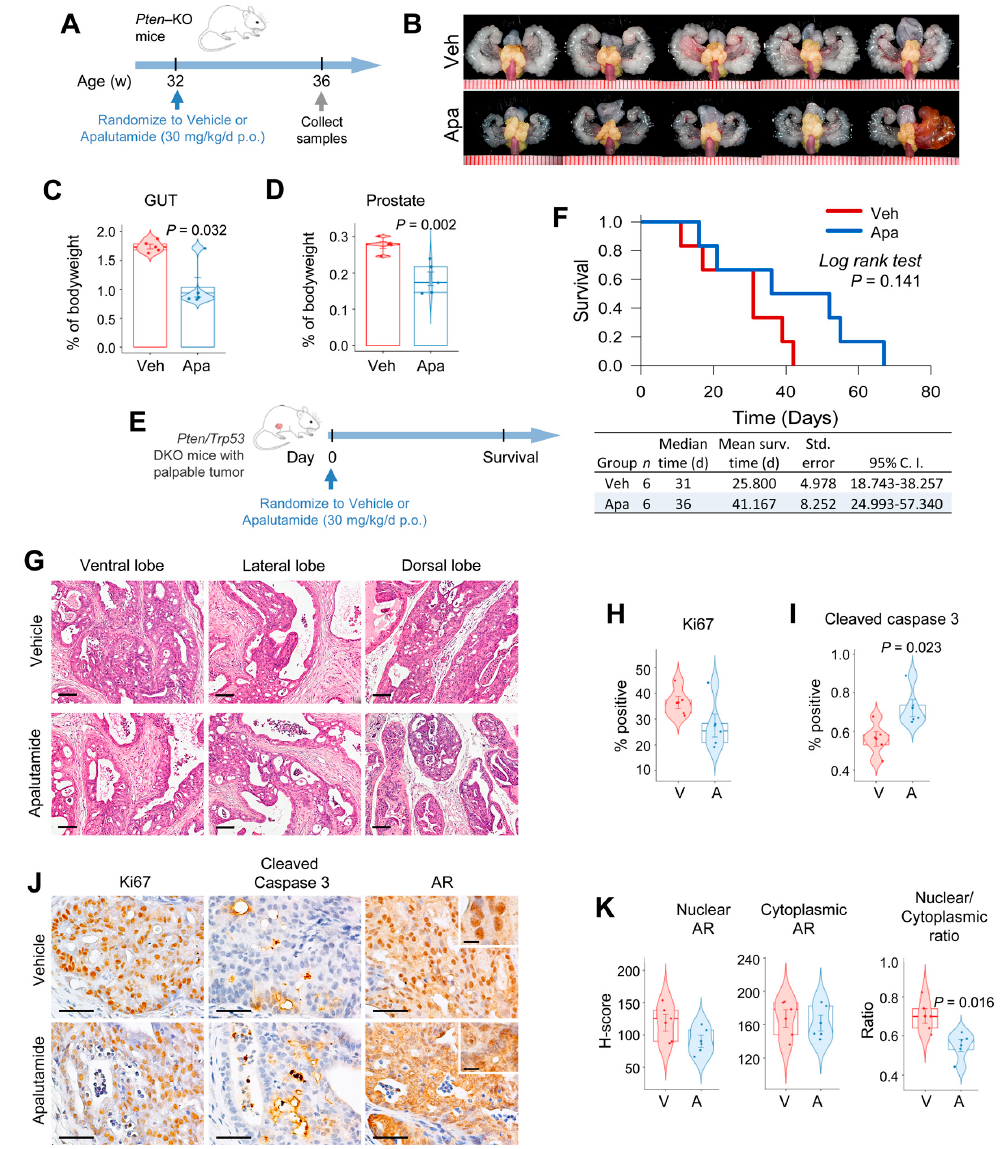
Figure 1. Apalutamide inhibits Pten -deficient castration-naïve prostate cancer (CNPC) growth. ( A ) The antitumor efficacy of apalutamide was evaluated in an early-stage prostate cancer intervention model using PSA Cre ; Pten loxP/loxP (KO) mice ( n = 5 mice/group). ( B ) Representative images of the genitourinary tracts (GUTs) collected en bloc; prostate tumors are high- lighted in yellow. Scale represents mm. The effect of apalutamide on normal secondary sex organs and prostate tumors was evaluated by comparing the genitourinary tract (GUT) weights ( C ) and antitumor activity was assessed by comparing the weights of the dissected prostates ( D ). ( E ) The therapeutic benefit of apalutamide was assessed in a late-stage model of advanced prostate cancer using PSA Cre ; Pten loxP/loxP /Trp53 loxP/loxP (DKO) mice randomized to treatment when the palpable tumors reached 5 mm. ( F ) Kaplan–Meier plots showing overall survival curves for mice after the indicated treatment. ( G ) Representative H&E-stained sections of KO mouse prostate tumors from ( A ) are shown. Scale bars = 250 μ m. Immuno- histochemical (IHC) quantification of cancer cell proliferation ( H ) and apoptotic rates ( I ) in KO mice treated with apalu- tamide. ( J ) Representative photomicrographs of prostate tumors from ( A ) immunostained with the indicated antibodies. Scale bars = 100 μ m and the inserted scale bar = 10 μ m. ( K ) IHC quantification of AR expression in mice from ( A ). For figure plots, horizontal bars represent the mean ± SE; center lines show the medians and box limits indicate the 25th and 75th percentiles; the violin plots show the distribution and the circles represent individual samples. Unless indicated, p values indicate significance of the Student t -test.